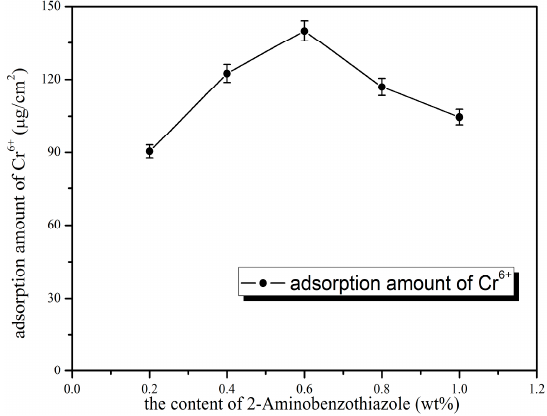
Figure 2. Effect of 2-aminobenzothiazole dosage on adsorption amount of Cr 6+ .